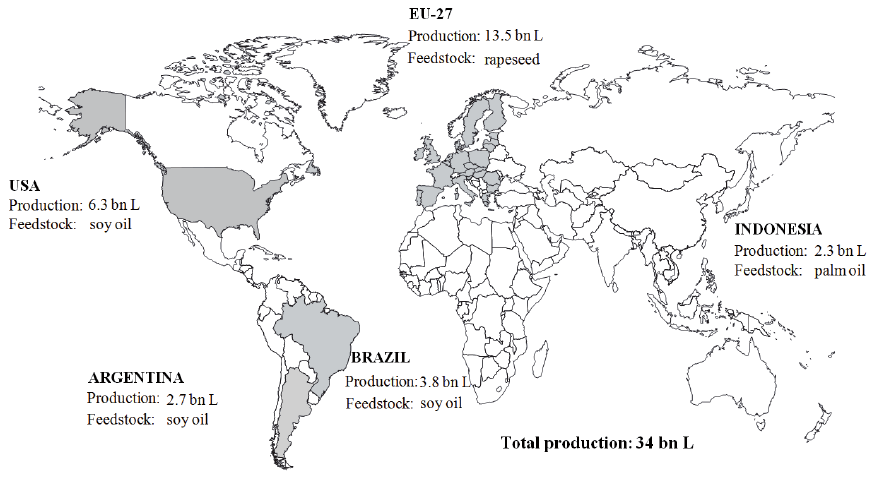
Fig. 3 – Word biodiesel production, average 2014-2016. Source: OECD/FAO